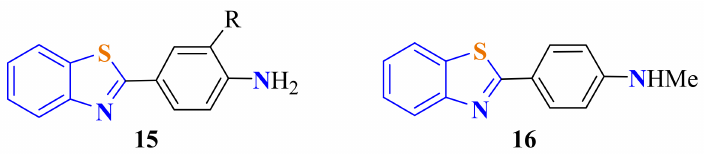
Figure 4. 2-(4-aminophenyl)benzothiazoles from the corresponding p -aminophenylbenzoic acid. 2-ChloromethylBT 17 (Scheme 9) was obtained in 62% yield by cyclocondensation of ATP with chloroacetic acid on heating in the presence of PPA at 180 ◦ C for 8 h [112].